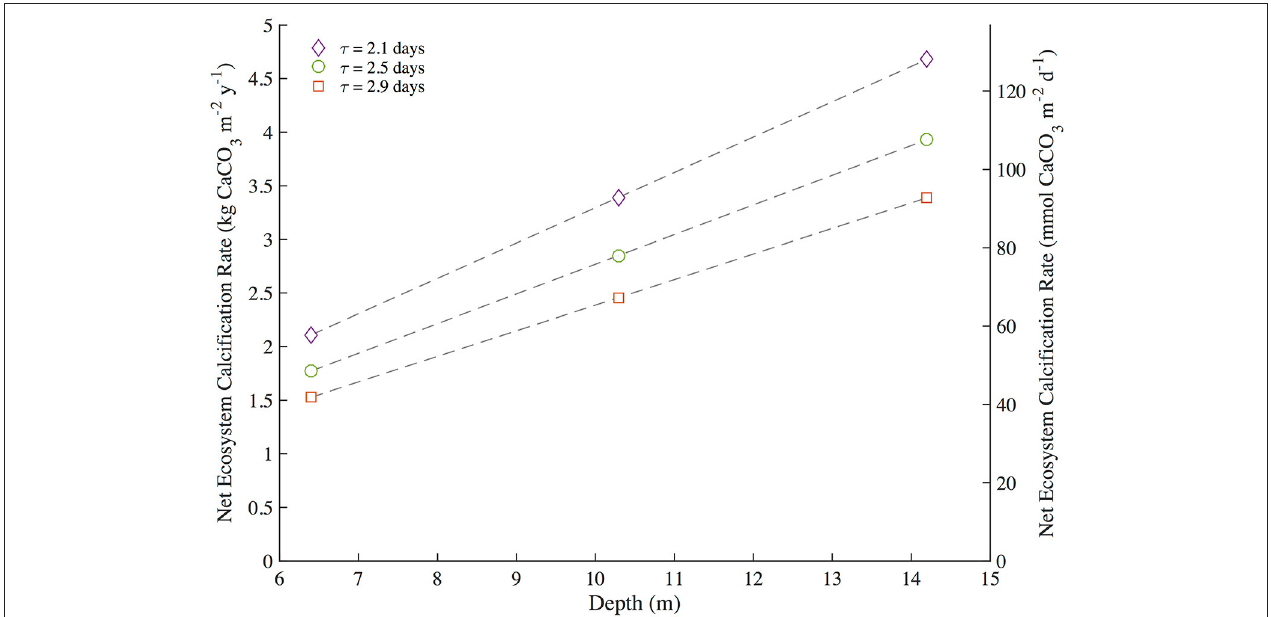
FIGURE 7 | Sensitivity analysis for bottle NEC at Hog Reef during the 2-year study period. Bottle Net Ecosystem Calcification (NEC) was calculated iteratively using mean depth ± one standard deviation (10.3 ± 3.3m) and mean residence time ± one standard deviation (2.5 ± 0.4 days) to determine the sensitivity of NEC to the interacting uncertainty and variability of these